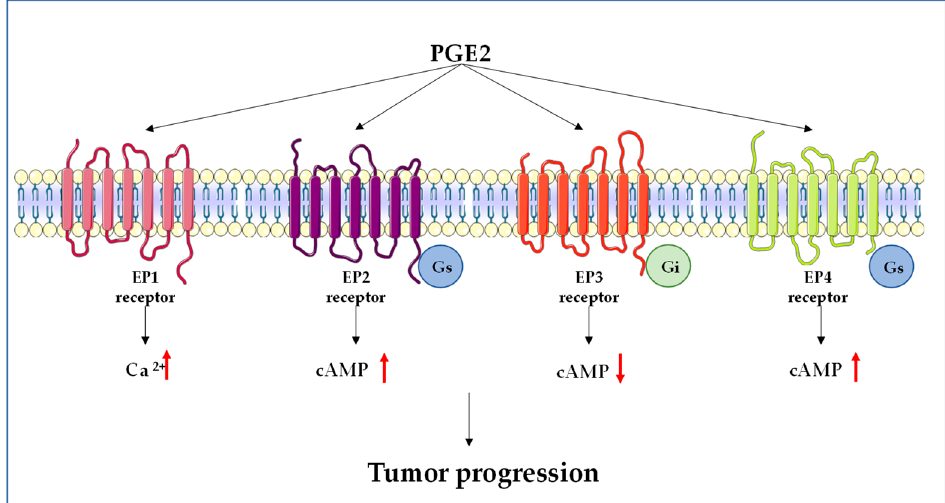
Figure 2. Schematic representation of EP receptors. PGE2 activity is mediated by the interaction with four G-protein-coupled receptors (GPCRs), namely, EP1–EP4 receptors. Each EP receptor possesses a distinct signaling pathway.